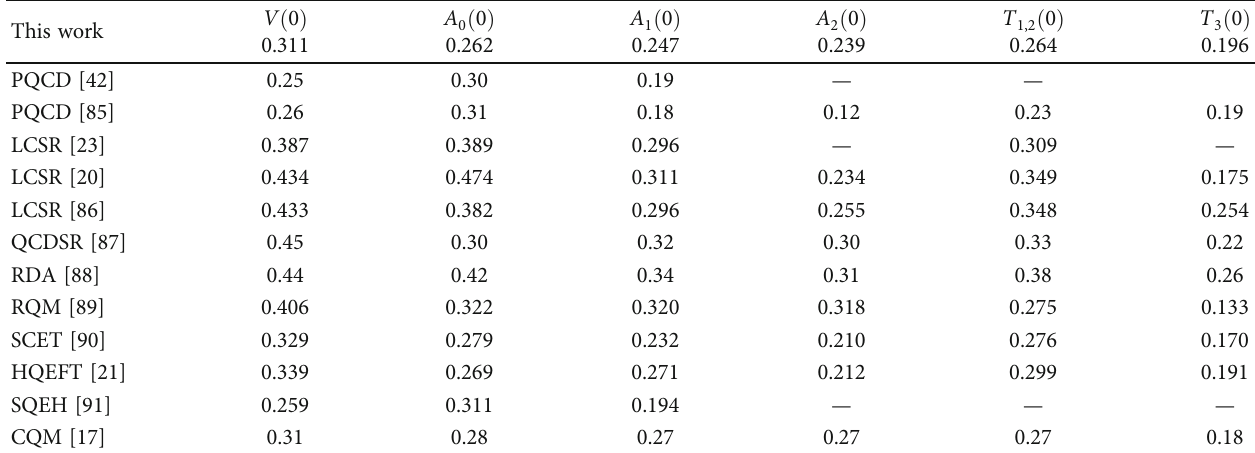
⟶ ϕ transitions at q 2 = 0 from di ff erent theories or s